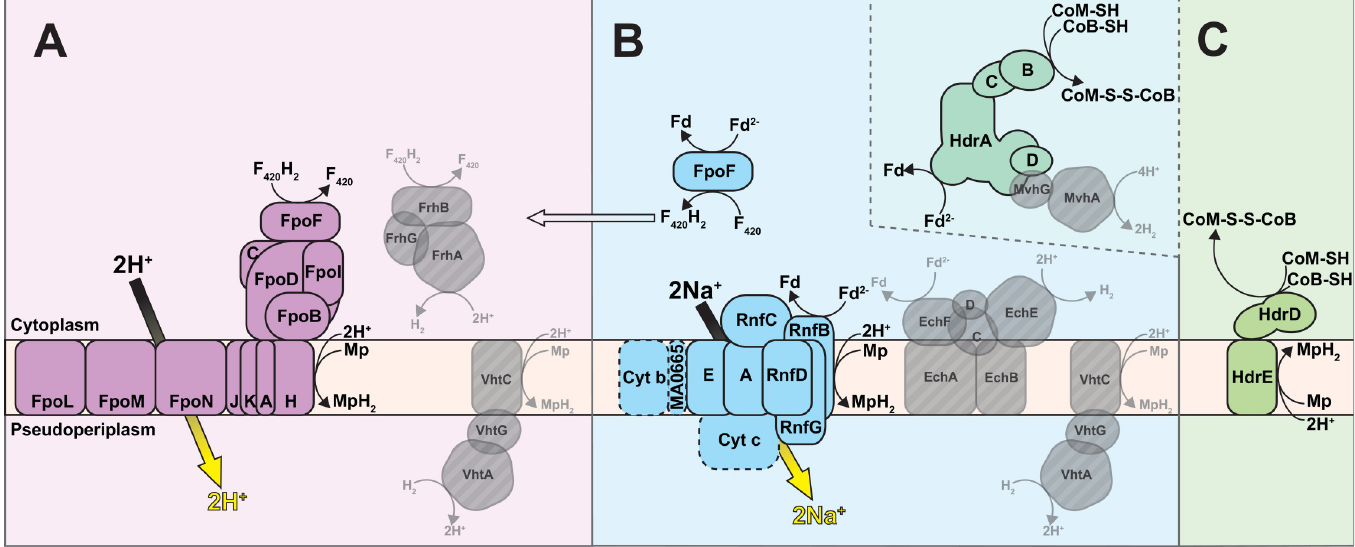
Fig 6. Cytoplasmic electron carrier oxidation. Some energy conservation systems discovered in methanogenic archaea are conserved in ANME archaea (colored fill), while others appear absent (transparent gray with diagonal line fill). ( A ) F 420 H 2 oxidation is coupled to proton translocation in methylotrophic methanogens via the Fpo/ Fqo complex or by the production of H 2 by Frh and subsequent oxidation by Vht. In either case, electrons are ultimately deposited on MpH 2 . Neither Frh or Vht complexes have been observed in any ANME genomes analyzed here. ( B ) Fd 2 − oxidation can be coupled either to sodium motive force or proton motive force in methylotrophic methanogens. The Rnf complex catalyzes Fd 2 − :Mp oxidoreductase reaction coupled to sodium translocation and is found in a number of methanogens and ANME. The ANME-2c contain most of the complex but lack the cytochrome c , cytochrome b , and MA0665 subunits, so their activity is difficult to predict. Ech and Vht can combine to produce net proton translocation via H 2 diffusion in methylotrophic methanogens, but neither complex is found in ANME. FpoF can catalyze a Fd 2 − : F 420 oxidoreductase reaction, and F 420 H 2 could then pass through the Fpo/Fqo complex. Various HdrABC complexes are present in all ANME genomes and could in principle oxidize Fd 2 − and CoM-SH/CoB-SH through a reversal of electron bifurcation reaction. The electron acceptor in this process is likely to not be H 2 in most ANME groups due to the absence of MvhG and MvhA. ( C ) Besides, the HdrABC complexes mentioned above and second possible CoM-SH/CoB-SH oxidation strategy would be a reversal of the HdrDE reaction found in methylotrophic methanogens. In ANME, the reaction would have to proceed in the direction illustrated and therefore would dissipate proton motive force by consuming a proton on the positive side of the membrane. For presence/absence of these systems in ANME genomes analyzed here, see S6 Fig. ANME, anaerobic methanotrophic; Ech, energy-conserving hydrogenase; Fpo, F 420 H 2 :methanophenazine oxidoreductase; Fqo, F 420 H 2 :quinone oxidoreductase complex; Frh, F 420 -reducing